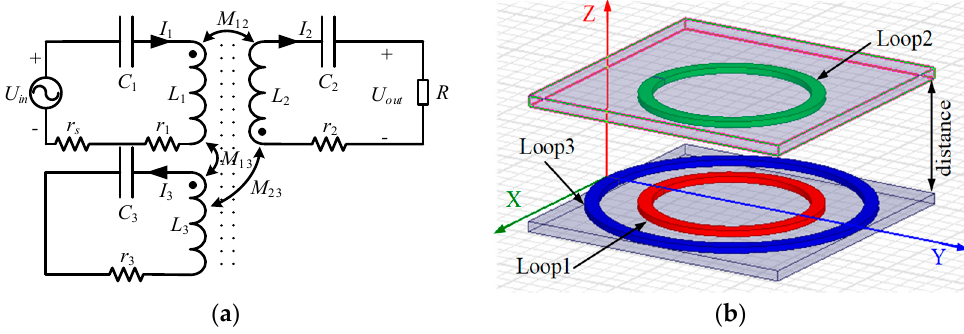
Figure 2. Resonant tank in ( a ) equivalent circuits model ( b ) 3D module in Maxwell.